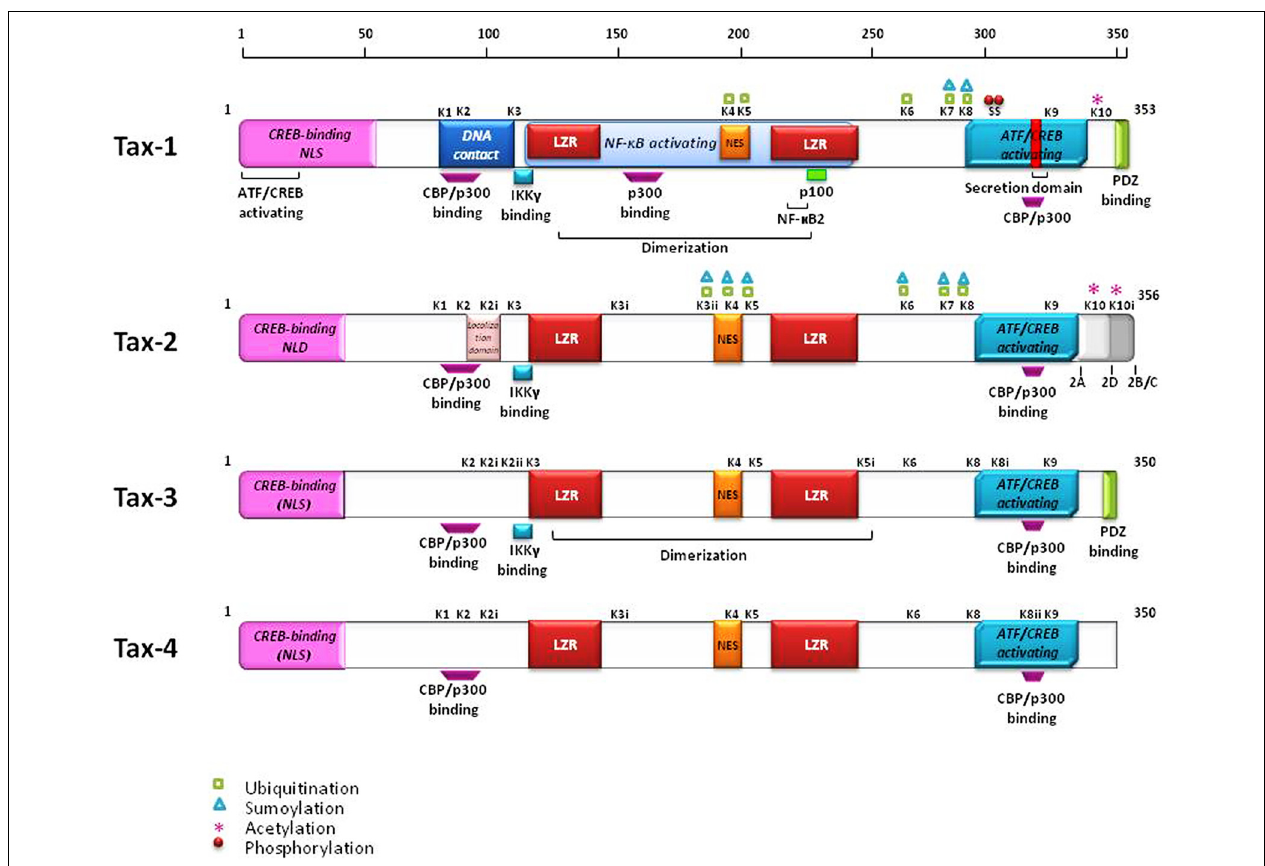
FIGURE 2 | Structural and functional domains of theTax proteins. The position of the lysines and their ubiquitination, sumoylation, and acetylation are indicated. Red dots identify phosphorylated serines.